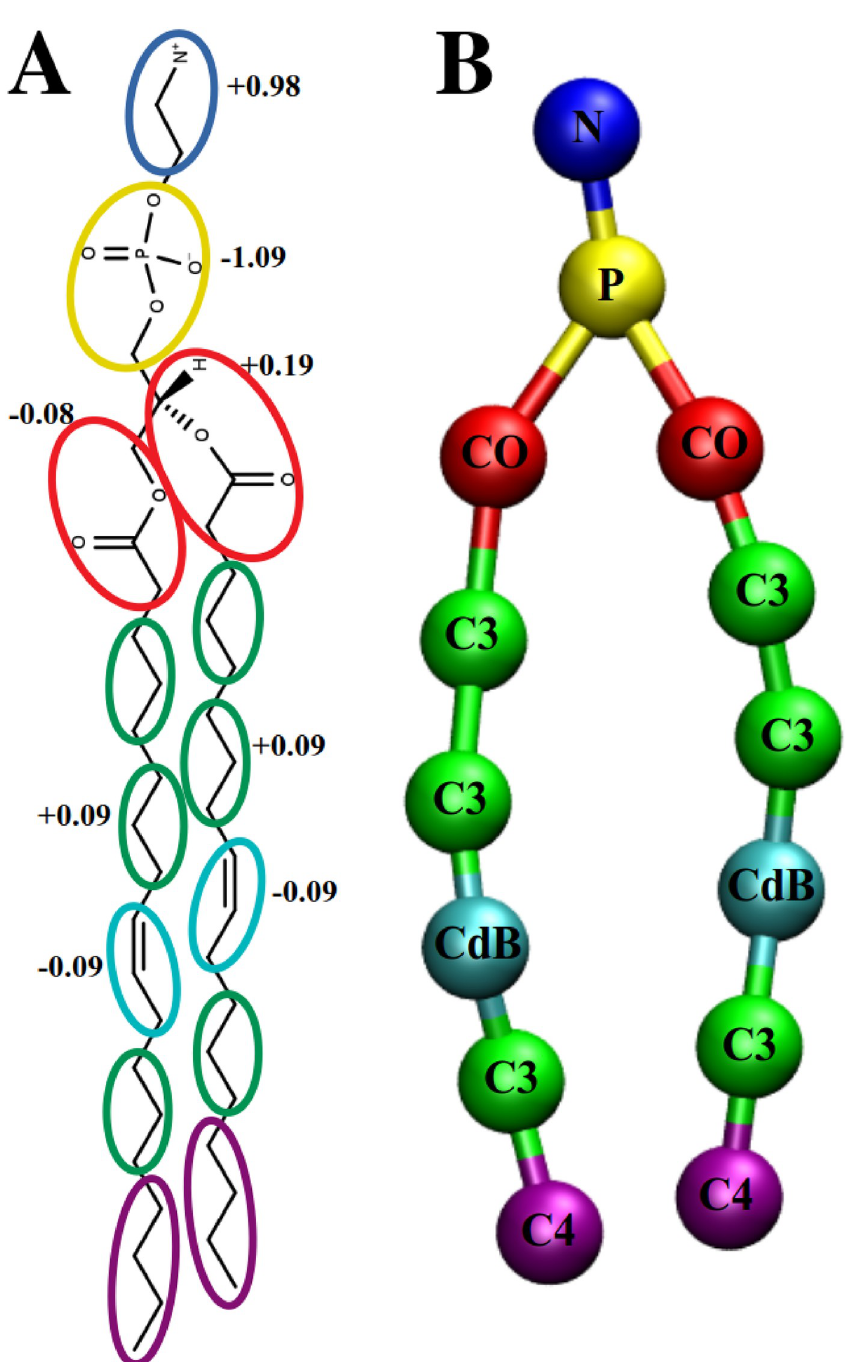
Fig 1. Mapping scheme of the DOPE molecule. (A) Atomistic representation of DOPE molecule showing atom groups constituting each CG site. Each type of CG site is shown in a separate color: blue bead—amine group, yellow bead—phosphate group, red beads—ester groups, green beads—propane groups, cyan beads—propene groups, and purple beads—butane groups. Non-zero charge of each CG site is shown next to it. (B) CG representation of DOPE molecule. Names of the CG sites as well as bonding between sites are shown.